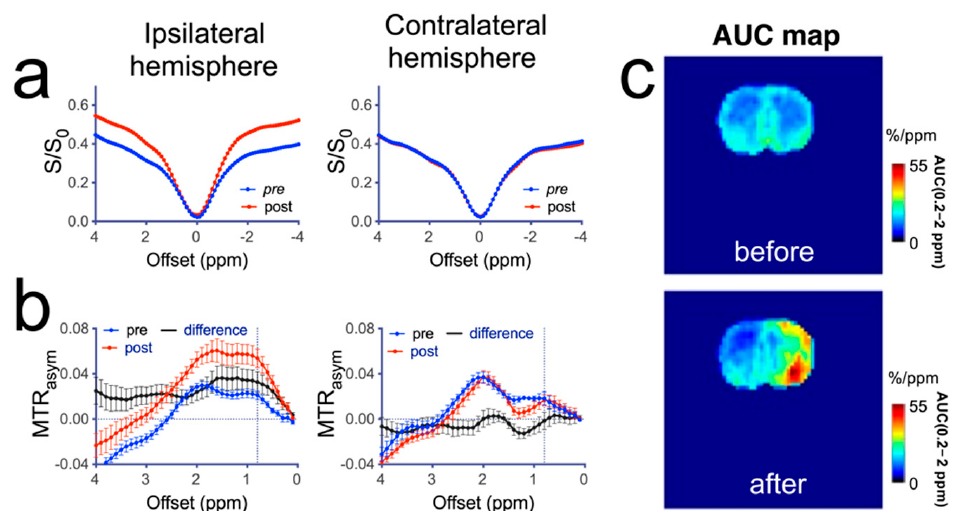
Figure 5. Quantitative analysis of CEST contrast in a representative rat infused with high dose (3 mL) of 25% mannitol solution. ( a ) Z-spectra obtained pre- and post-mannitol infusion in the ipsilateral (right) and contralateral (left) hemispheres. ( b ) MTR asym plots of pre- and post-mannitol infusion in the ipsilateral (right) and contralateral (left) hemispheres. ( c ) AUC (0.2–2.0 ppm) maps before and after the infusion of mannitol.